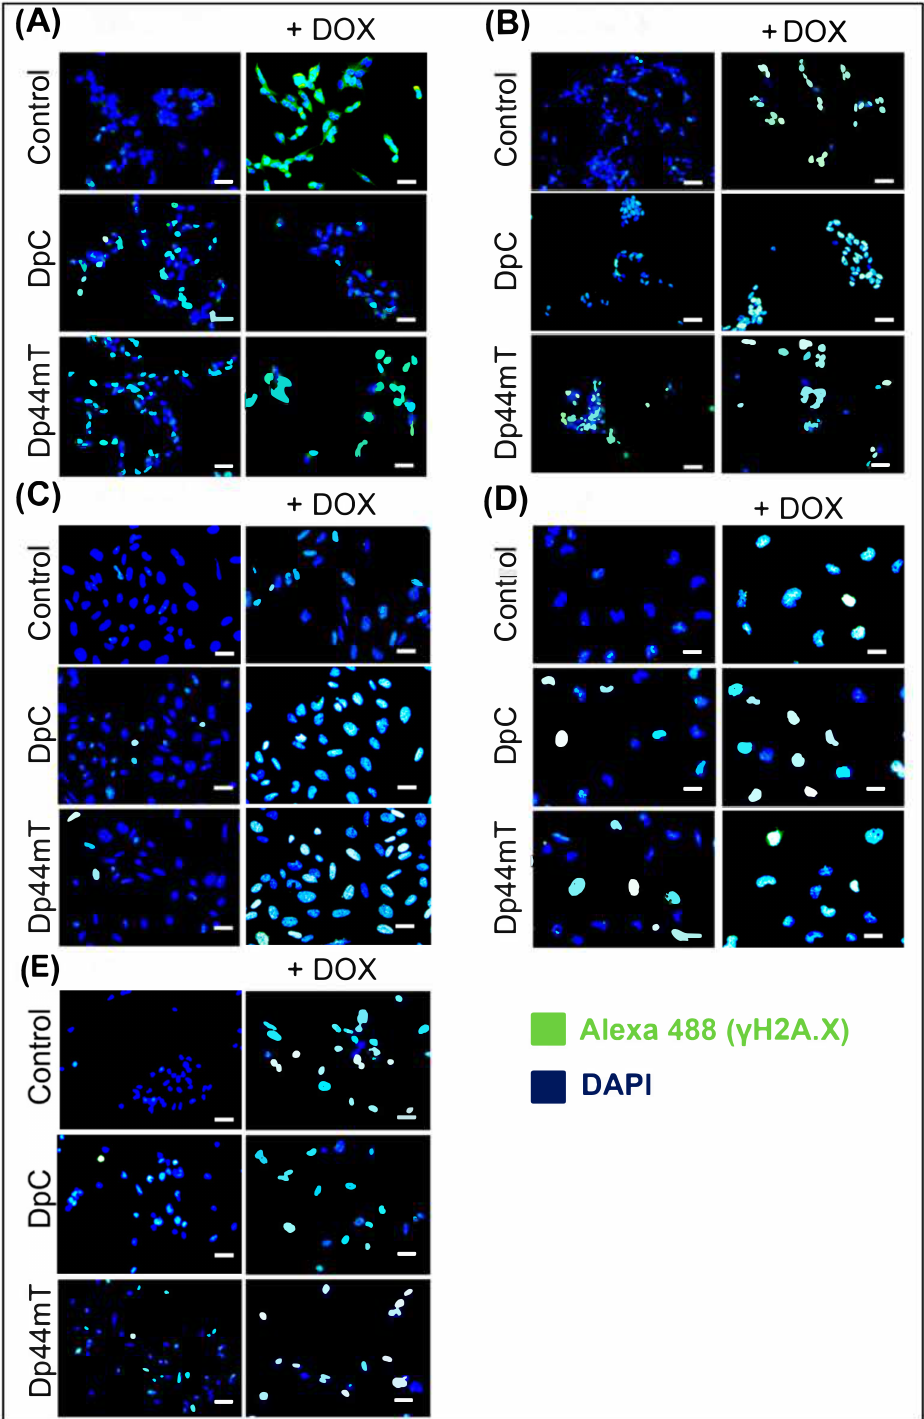
Figure 7. Detection of double-strand breaks (DSBs) in DNA using immunofluorescence staining of phosphorylated γ -H2AX protein. Detection of DSBs in SH-SY5Y ( A ), SK-N-BE(2) ( B ), Saos-2 ( C ), Daoy ( D ), and RD ( E ) cells after 48 h of treatment with IC 50 doses of DpC, Dp44mT, DOX, or their combination was performed by fluorescence microscopy. Phosphorylated γ -H2AX protein (a DSB marker) was visualized by indirect immunofluorescence using an anti- γ -H2AX primary antibody and Alexa-488-conjugated secondary antibody (green fluorescence). The nuclei were labeled by DAPI (blue fluorescence). The scale bars represent 50 µ